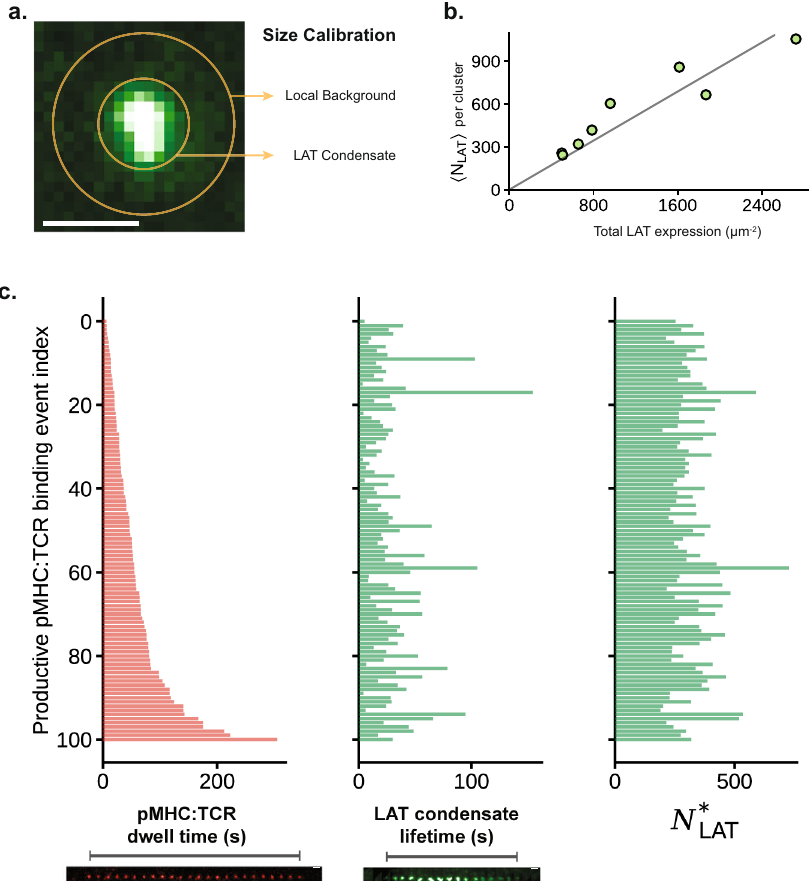
Fig. 2 | Physical properties oftheLAT condensate.a Anannulus around the LAT condensateisusedtosamplethelocalbackground.Theintensityofthecondensate iscalculatedasthemidpointofthenetintensityandtotalintensity,sincetheextent of background LAT clustering is unknown. Scale bar is 1 μ m. b Scatter plot of the average number of LAT within condensates, h N LAT i , as a function of the total LAT expression level (endogenous LAT + exogenous LAT-eGFP). Each point is a cell average overcondensatesobserved withinthe fi rst 5min ofcell landing. The fi tted line hasthe equation y =0 : 43 x , whichwasconstrained tohave0intercept. Allcells werefromthe samemouse.Cellsfrom twoothermiceyieldedsimilar fi ts, y =0 : 51 x